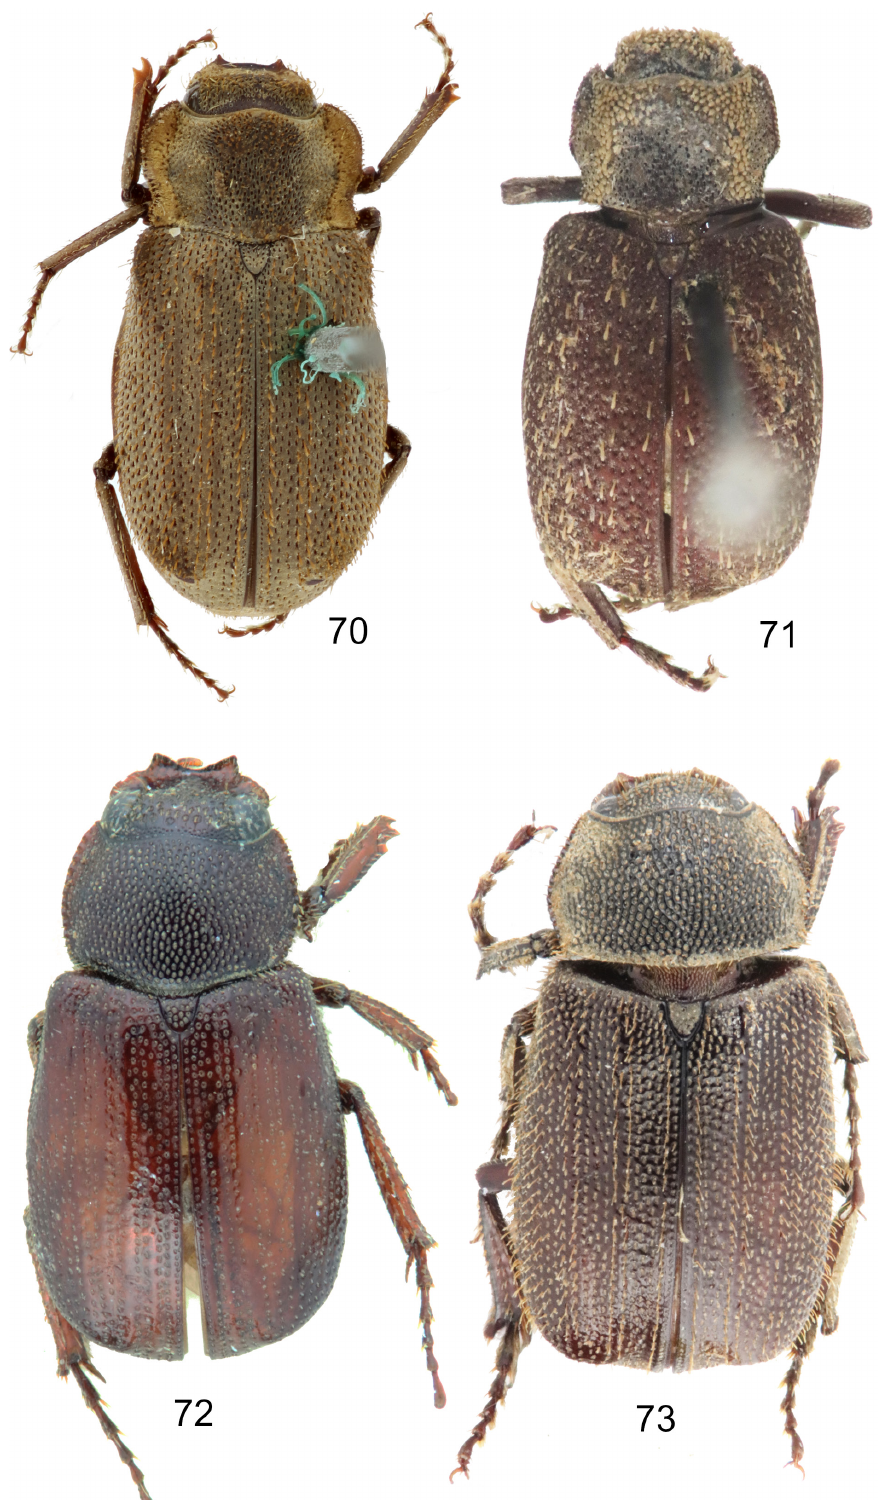
Figs 70–73. Papuan and Wallacean Maechidius Macleay, 1819, habitus, dorsal view. 70 . M. opatroides Arrow, 1941 comb. rest., lectotype, ♀ (BMNH). 71 . M. pauxillus Heller, 1910 comb. rest., lectotype, ♂ (SNSD). 72 . M. pedarioides Arrow, 1941, syntype, ♂ (BMNH). 73 . M. peregrinus Lansberge, 1886, ♂ (DTC). Not to